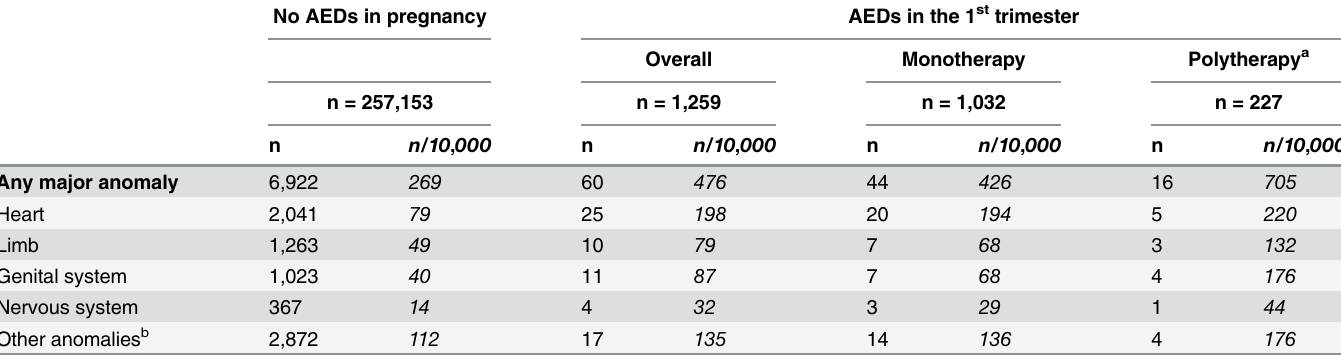
Table 2. Absolute risks (per 10,000 children) of major congenital anomalies in children according to their mothers ’ prescriptions of antiepileptic drugs in pregnancy *